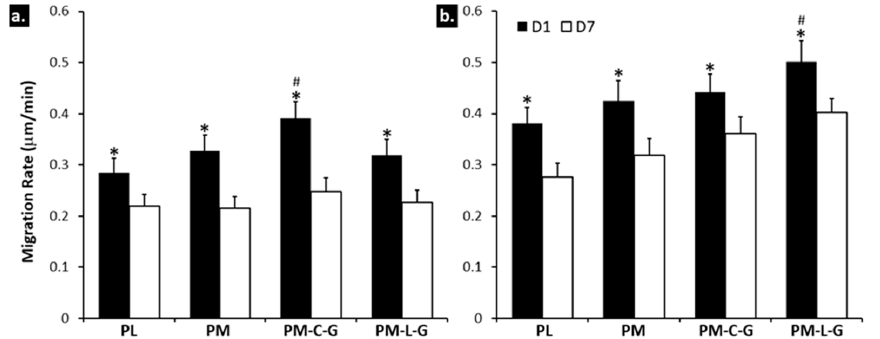
Figure 10. Migration rate of ( a ) fibroblast ( b ) myoblast. # indicates significant difference between groups, * indicates significant difference of fibroblasts/ myoblasts between day 1 and day 7 from same group of culture condition.